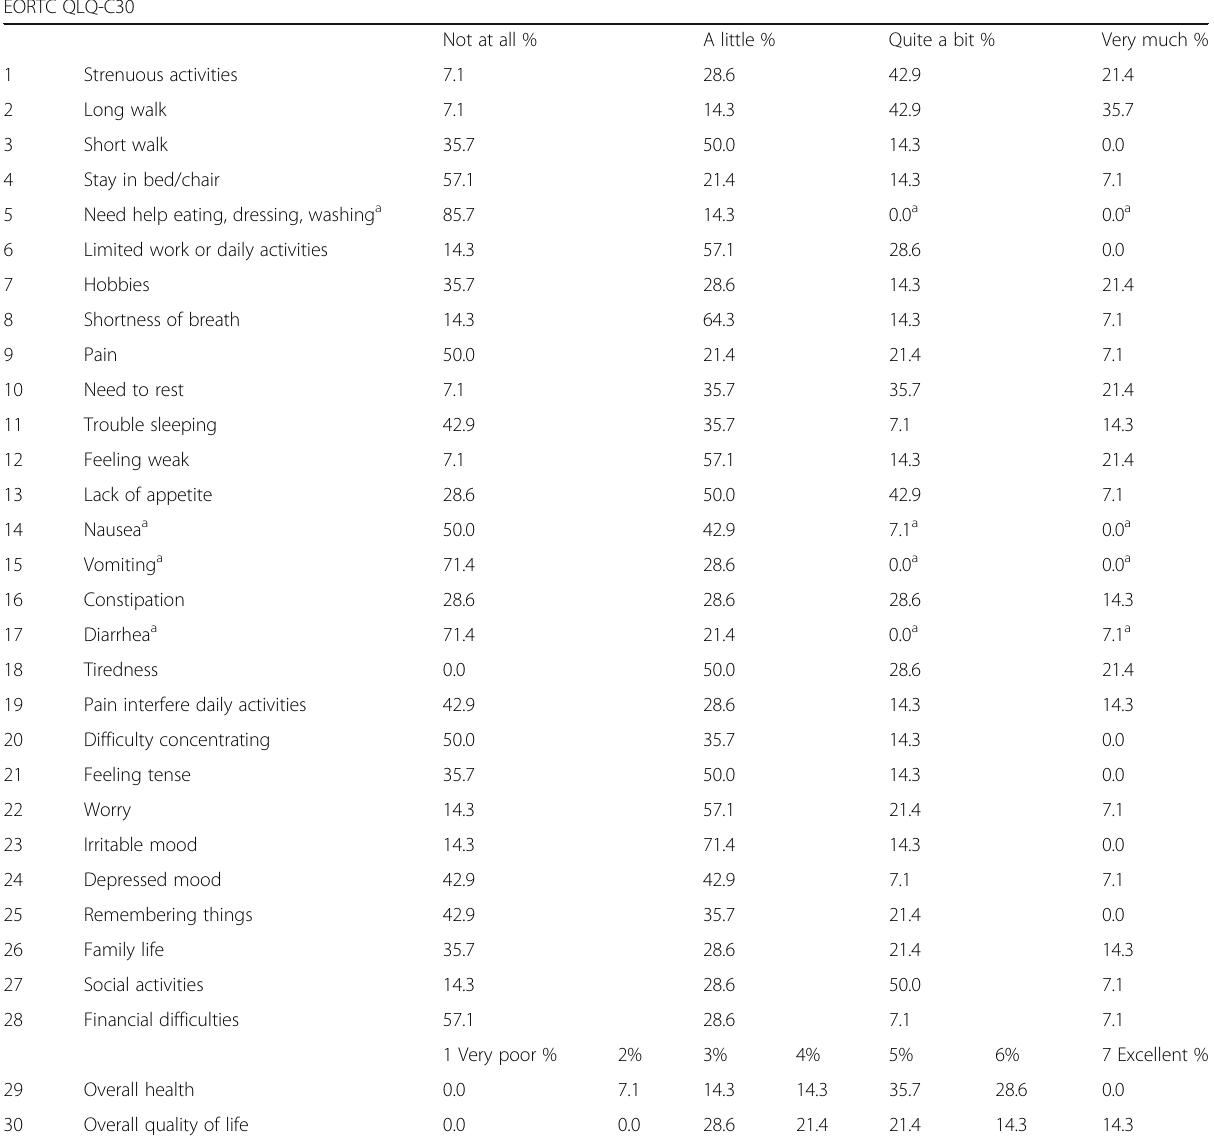
Table 4 EORTC QLQ-C30: Item-level endorsement frequencies ( n = 14) from Stage 1 EORTC QLQ-C30